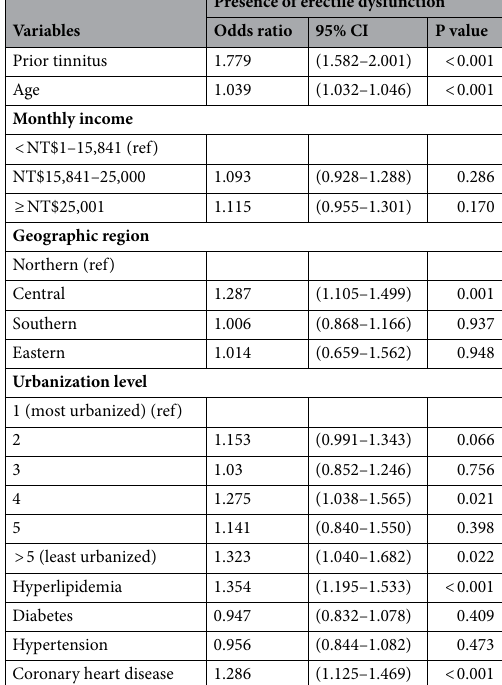
Table 3. Covariate-adjusted odds of prior tinnitus among erectile dysfunction patients vs. controls (n = 38,658). CI confidence interval.